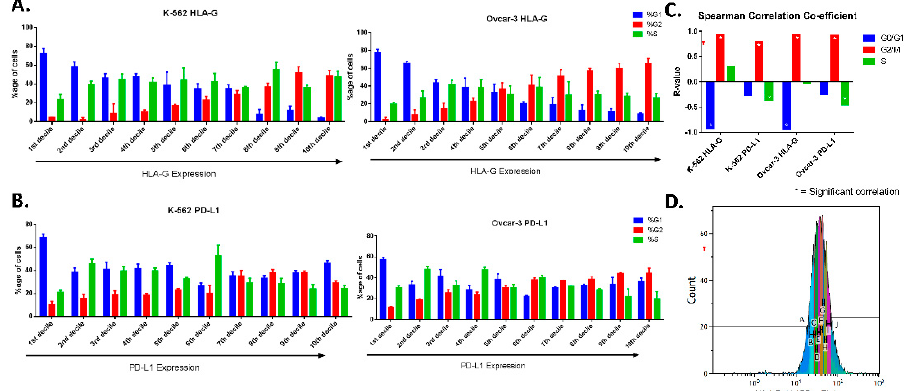
Figure 2. Cell cycle phases based on expression of HLA-G and PD-L1 (FACS). OVCAR-3 and K-562 cells were stained for HLA-G (a) and PD-L1 (b). Cell cycle analyzed after gating protein expression peak in 10 equal parts (deciles; A-J) in increasing protein expression. ( A ). For HLA-G, both the cell lines showed that the cells present in first deciles (low expression) were mainly in G0 / G1 phase, while those in higher deciles have the majority of the cells in G2 phase. ( B ). For PD-L1, The G0 / G1 and S-phase cells showed similar percentage of cells present in each phase among di ff erent gates (from low to high expression). The G2 phase cells were present more in higher intensity gates compared to lower ones. ( C ). The FACS analysis showed strong positive correlation of G2 phase (r s > 0.9) with HLA-G and PD-L1 in both the cell lines, while strong negative correlation of G0 / G1 phase was found only for HLA-G (r s > 0.9) but not with PD-L1. The S-phase did not show any correlation for HLA-G with either of the cell lines, and weak negative correlation (r s = − 0.3) was found for PD-L1. ( D ). An image of the peak expression gated for 10 deciles marked as A to J with increasing expression of the protein.